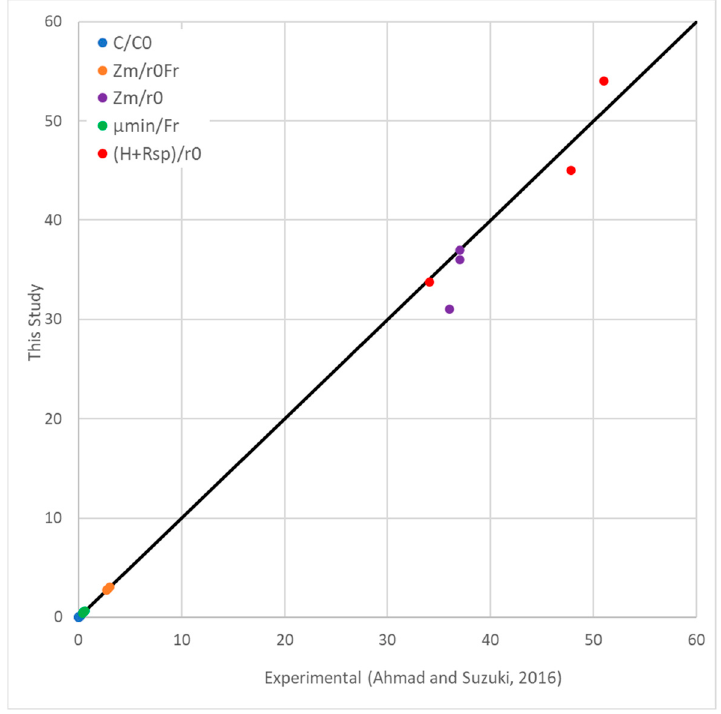
Figure 11. Numerical results (from current study) against experimental data [11] for different parameters.